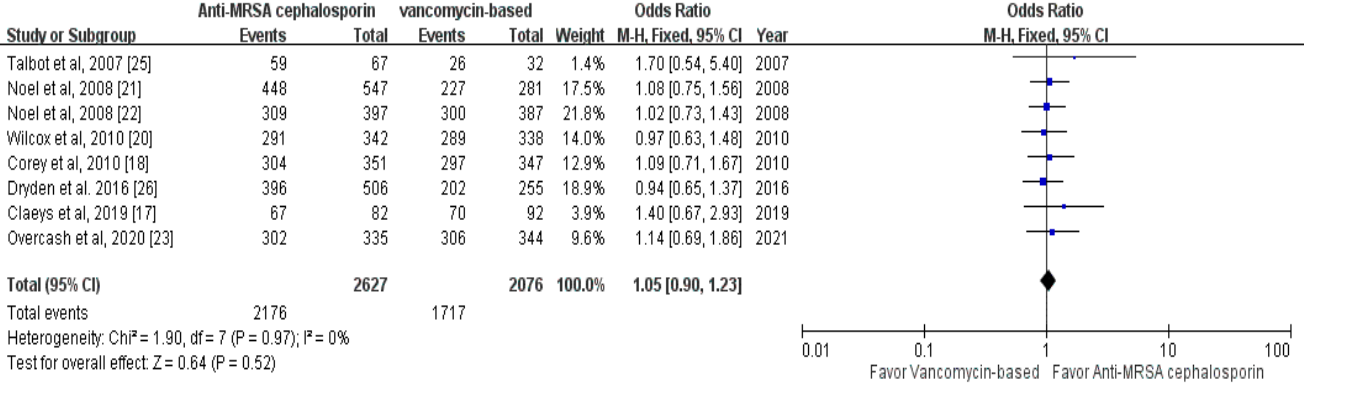
Figure 3. Forest plot of the comparison of clinical response rates between anti-MRSA cephalosporin-based and vancomycin-based treatments.